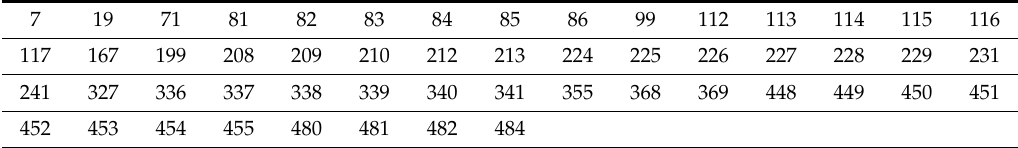
Table 10. x1 and x2 corresponding to block P texture template